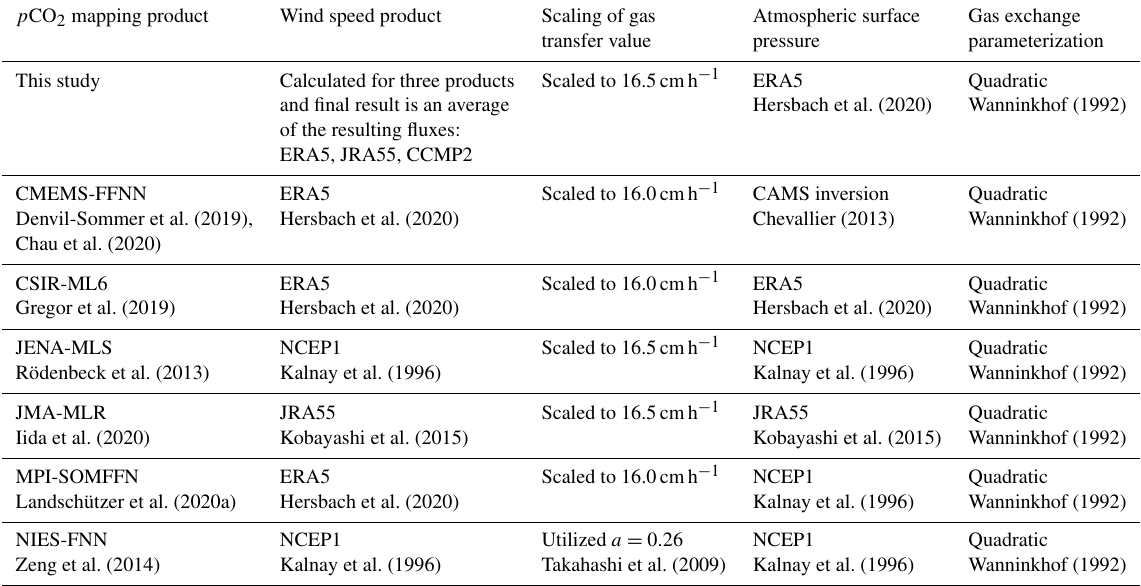
Table A1. Summary of parameters used to calculate flux.